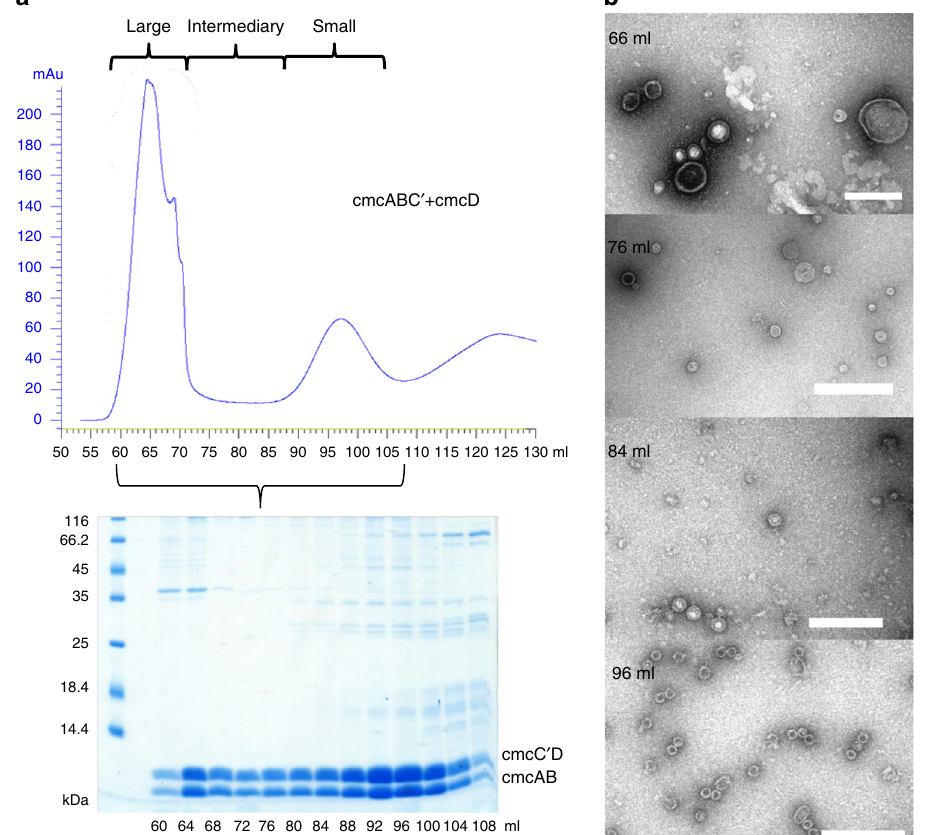
Fig. 2 Characterization of cmcABC ′ + cmcD BDPs. a Gel fi ltration of sedimented BDPs and SDS-PAGE analysis of the fractions. Two noticeable BDP peaks were formed: one immediately after the empty volume of 60 ml (large type particle zone) and one at approximately 90 – 100 ml (small type particle zone). An intermediary zone with smaller BDP protein amounts was formed between these two zones. b Examples of TEM analysis of the BDP samples in the large particle zone (66 ml), intermediary zone (76 and 84 ml), and small particle zone (96 ml). Scale bar: 200